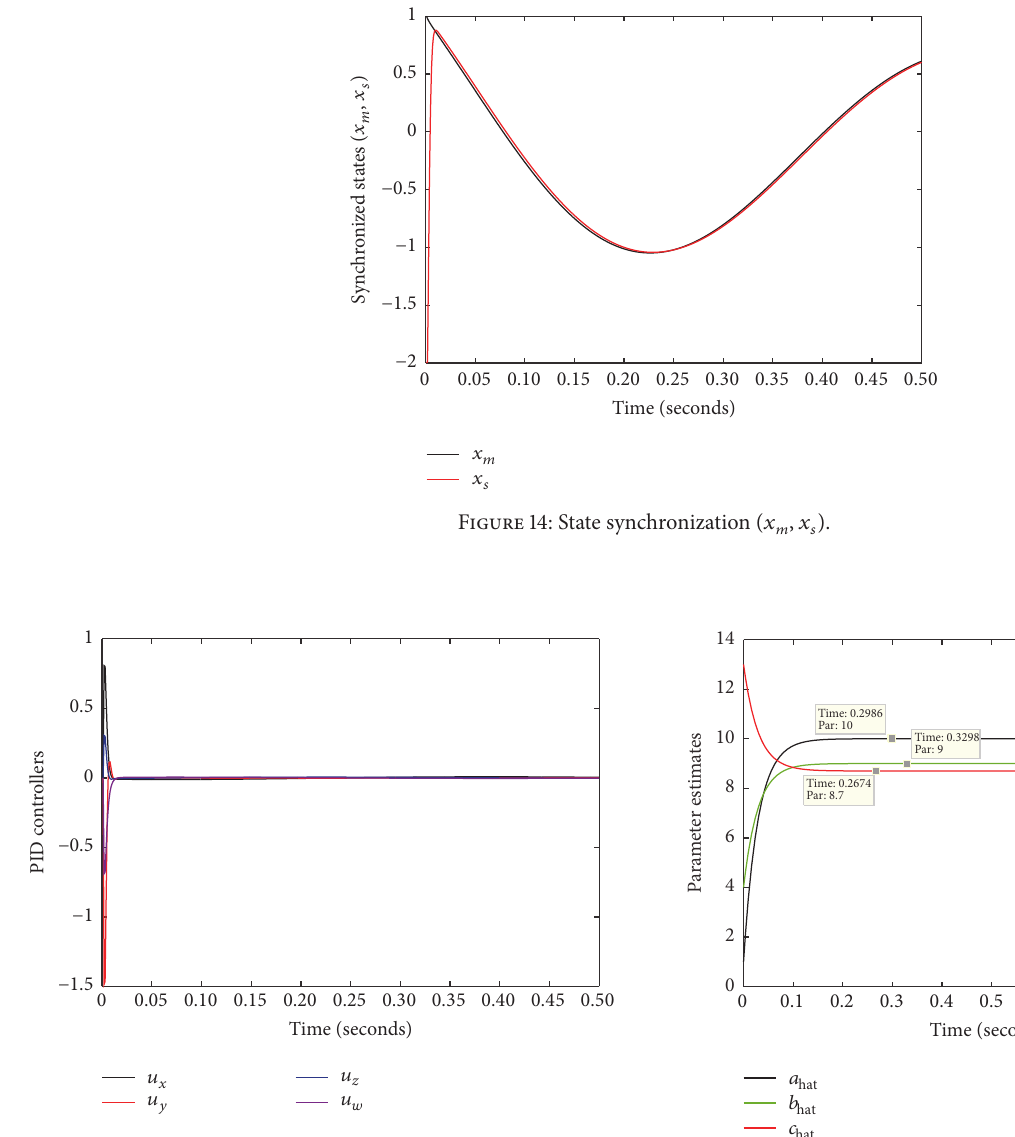
Figure 15: Time history of PID controllers 𝑢 𝑥 , 𝑢 𝑦 , 𝑢 𝑧 , and 𝑢 𝑤 .